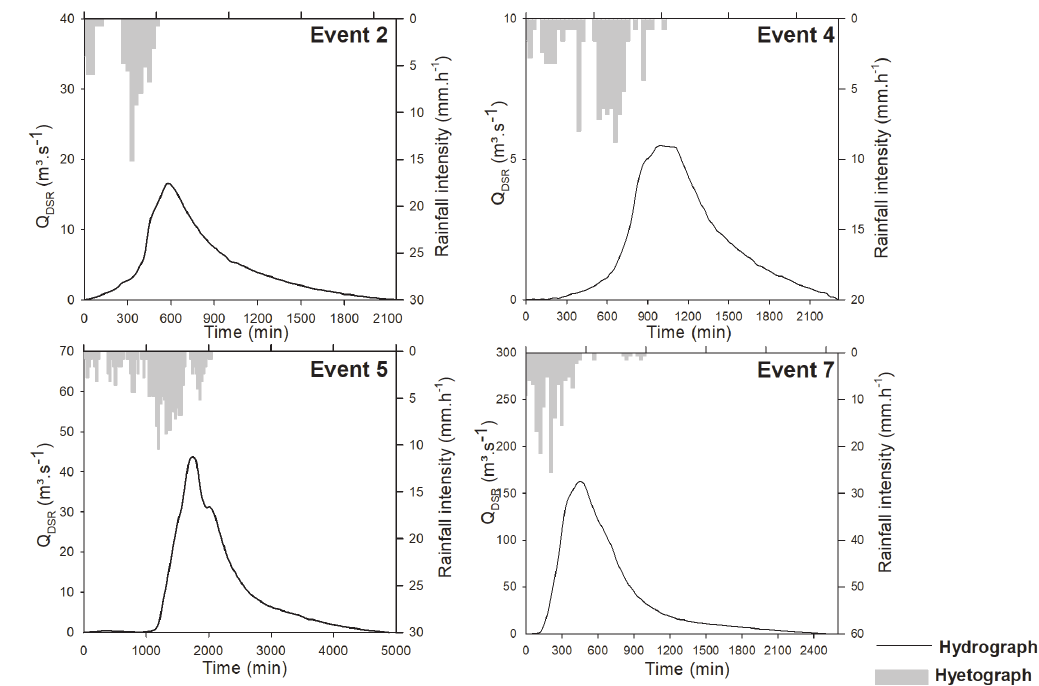
Figure 3 - Illustration of some rainfall-runoff events analyzed in CRW.